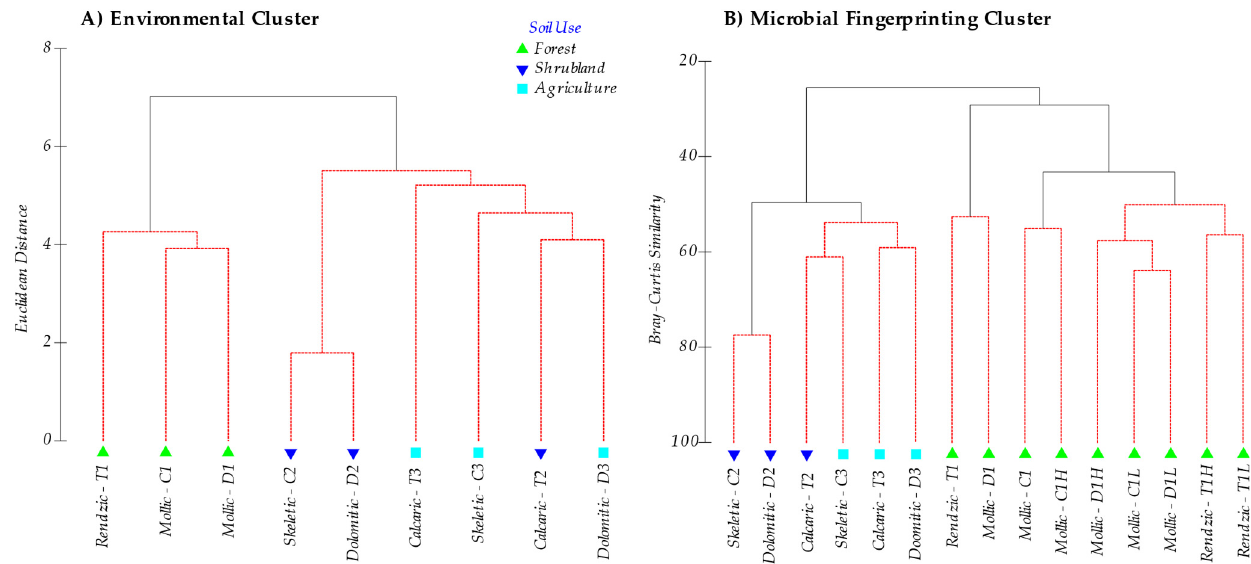
Figure 1. ( A ) Cluster analysis based on Euclidean distance of all environmental data (Table 2). ( B ) Cluster analysis derived from DGGE (fingerprinting) analysis of the microbial community based on the Bray Curtis similarity with the results of all the DGGE profiles for the different microbial communities analysed (Bacteria, Archaea and ectomycorrhizal Fungi). Note that, for the latter, the sub-horizons of forest soil are differentiated. Soils are labelled as parent material (T: Marl and limestone; C: Limestone; D: Dolomites), soil use (1: Forest; 2: Shrubland; 3: Crops) and O-horizon